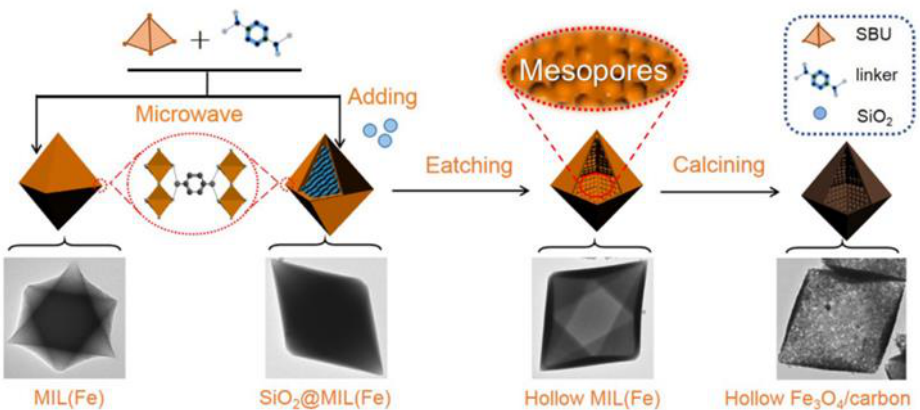
Figure 1. Scheme on the formation of a hollow MIL (Fe) and its derivatives. Reprinted with permission from Ref. [25]. Copyright 2019, Elsevier.